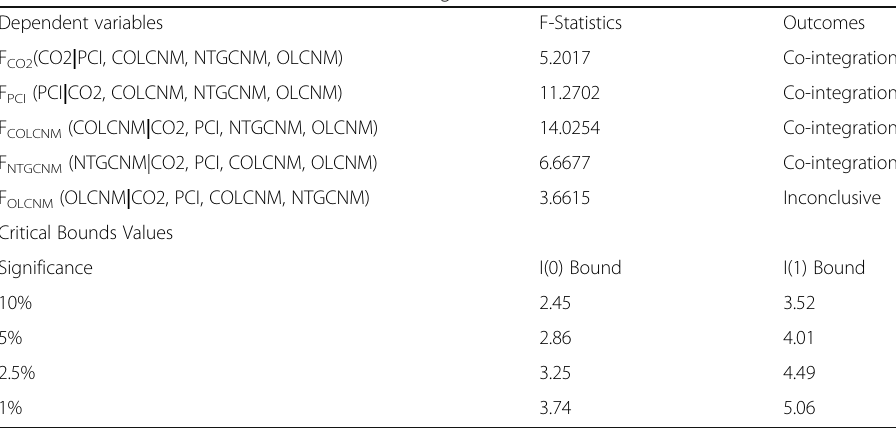
Table 4 Bounds test for the existence of Co-Integration Dependent